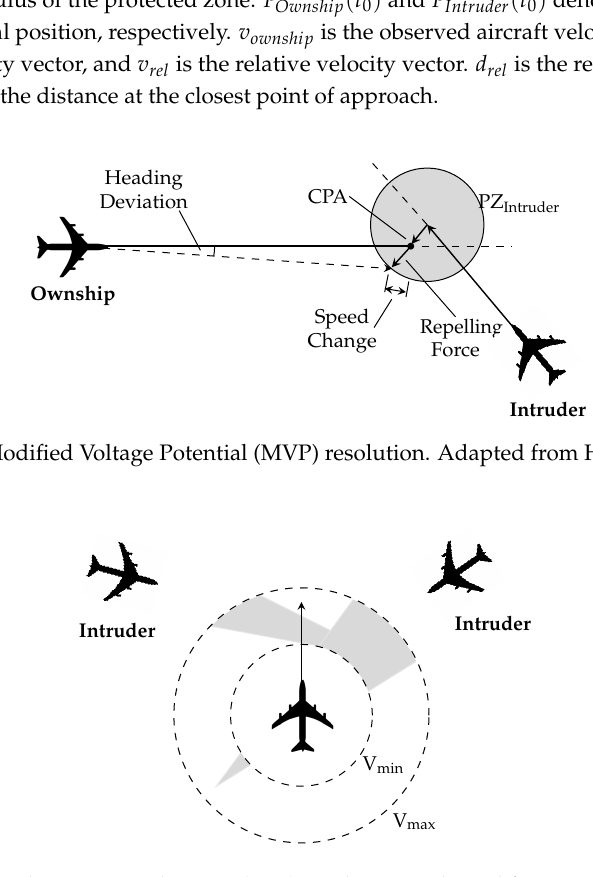
Figure 9. Solution space diagram (SSD) resolution. Adapted from Van Dam